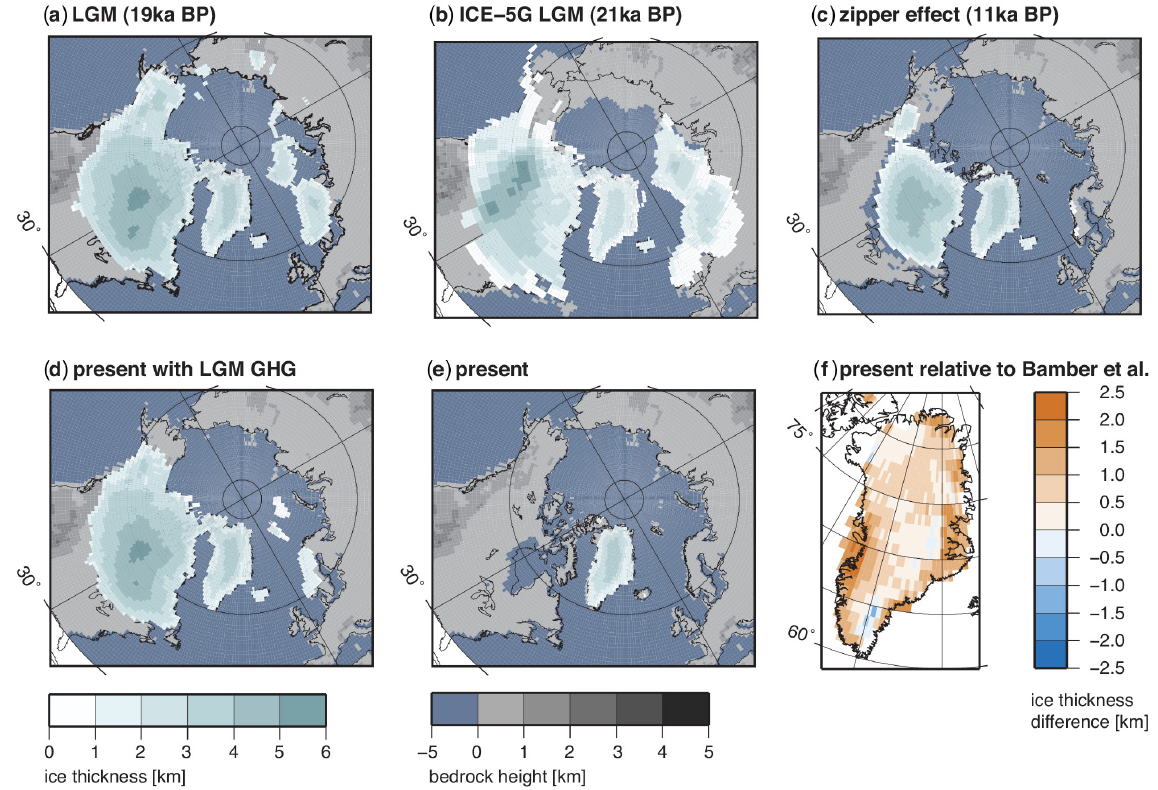
Figure 3. Bedrock height and ice sheet thickness (a) at the Last Glacial Maximum (LGM) as simulated with IcIES–LOVECLIM, (b) at the LGM according to ICE-5G reconstruction (Peltier, 2004), (c) at 11kaBP, which is when the Cordilleran and Labrador ice sheets separate in CTR (zipper effect), (d) as simulated for present (0kaBP), assuming that atmospheric greenhouse gases (GHGs) remained constant at their LGM values (21kaBP), (e) at present in CTR. (f) Ice thickness at present in CTR relative to observations (Bamber et al., 2001; Layberry and Bamber, 2001). Black contours show observed present-day coastlines for